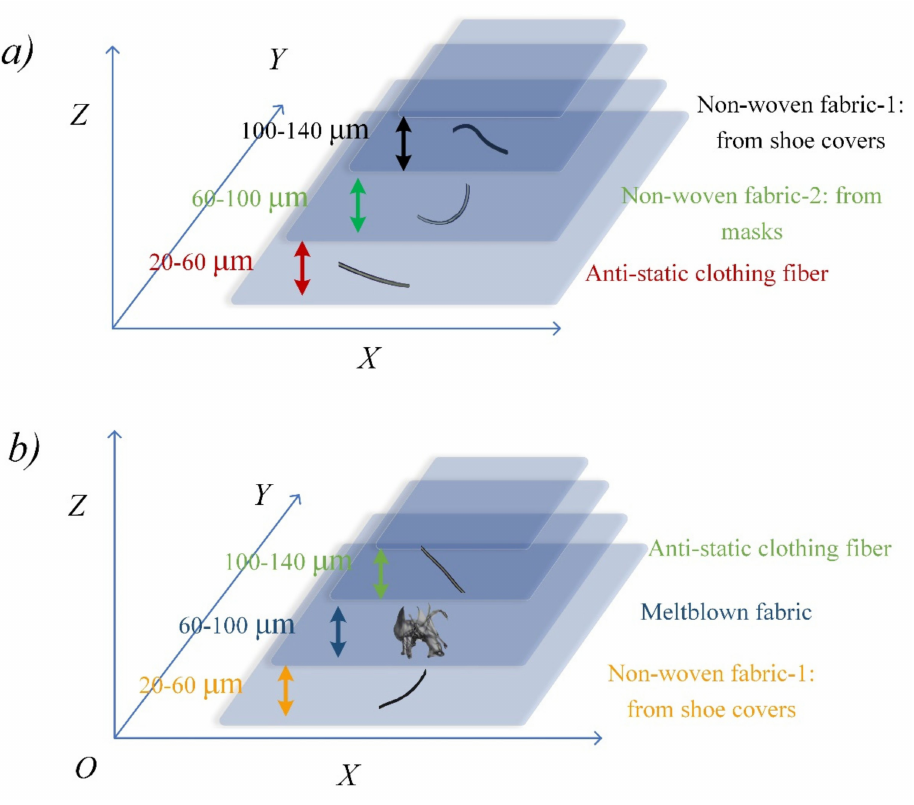
Figure 6. Structure of the sample, ( a ) the first sample and ( b ) the second